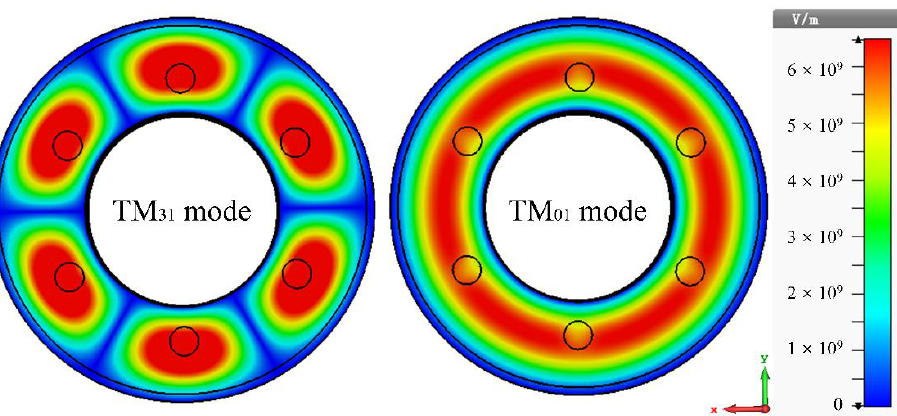
Figure 3. The difference between the electric distribution of TM 31 mode and the electric distribution of TM 01 mode in an X-Y cross section.